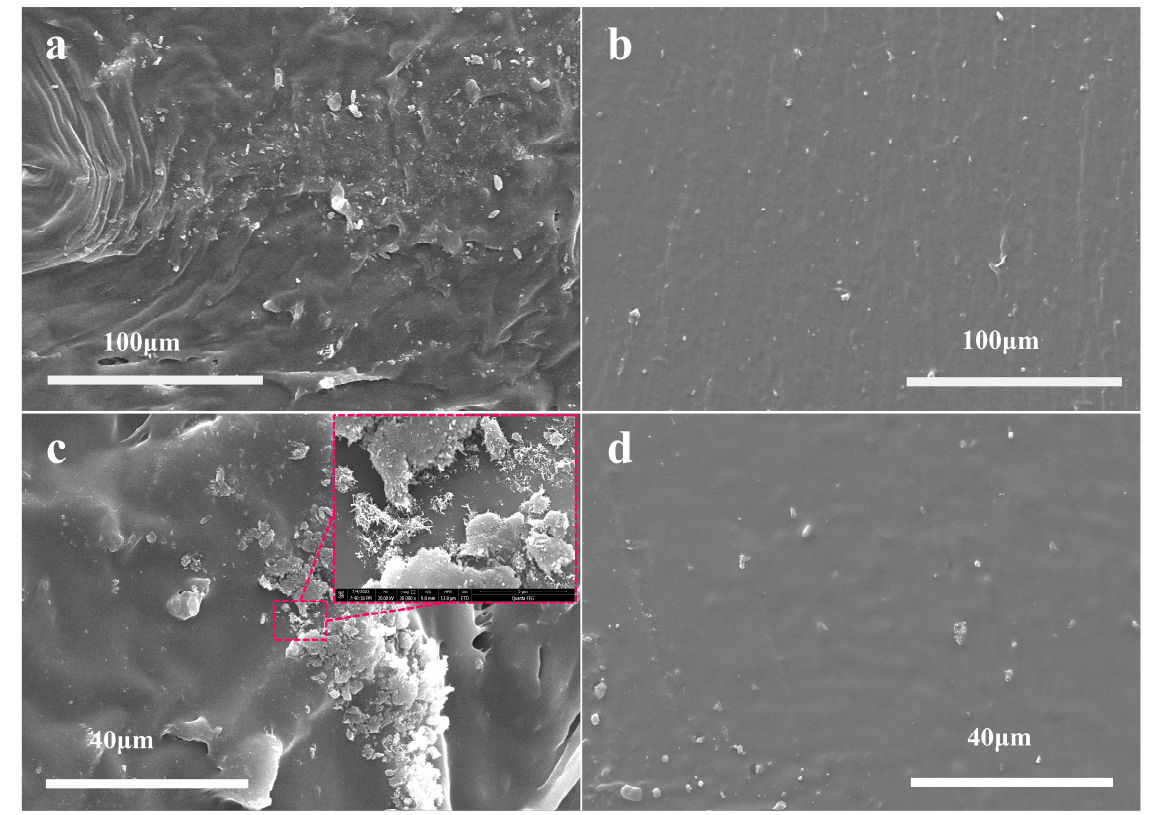
Figure 4. SEM images of cross-section of OCWPU and OCNT/WPU composites films: ( a , c ) OCWPU. ( b , d ) OCNT/WPU.